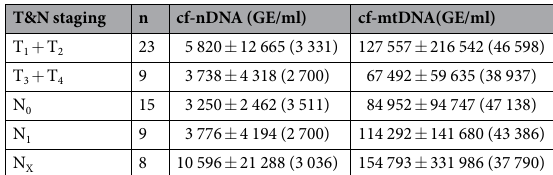
Table 3. Comparison of cf-nDNA & cf-mtDNA and the primary tumor (T) and regional lymph nodes (N). Data are expressed as mean ± standard deviation (median). GE-genome